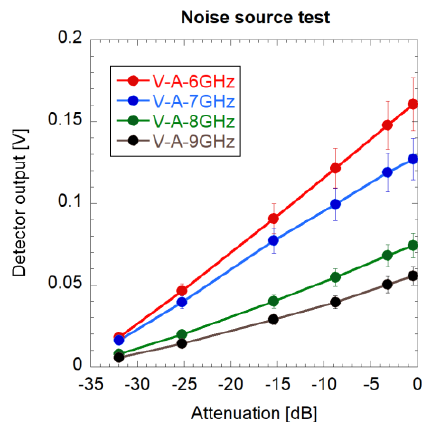
Fig. 10. Radiometer integrated test results with a noise source. Change in signal strength from the filter bank when the RF input signal to the mixer was controlled by adjusting the attenuator to vary the strength of the input signal from the noise source. V-A-6, 7, 8, and 9 GHz correspond to BPFs at 54, 55, 56, and 57 GHz, respectively.